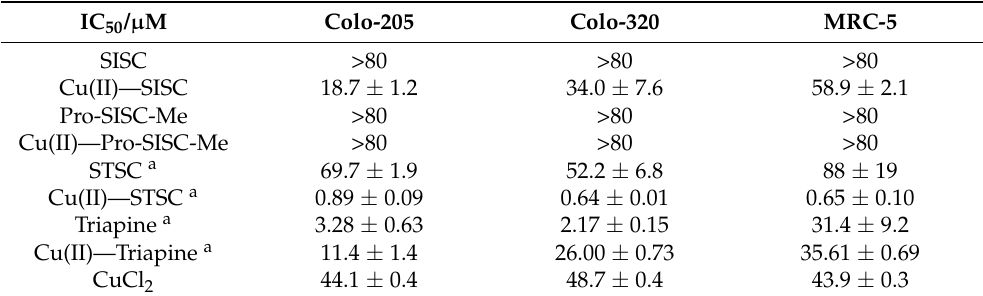
Table 4. Measurements were also performed in the presence of one equivalent Cu(II) ions and comparative data for STSC and Triapine are also shown (Table 4). Table 4. In vitro cytotoxicity of SISC, Pro-SISC-Me, STSC and Triapine, their Cu(II) complexes formed at 1:1 metal-to-ligand ratio, and CuCl 2 expressed as IC 50 values in Colo-205 and Colo-320 human colon adenocarcinoma and MRC-5 human lung fibroblast cells. Exposition time: 72